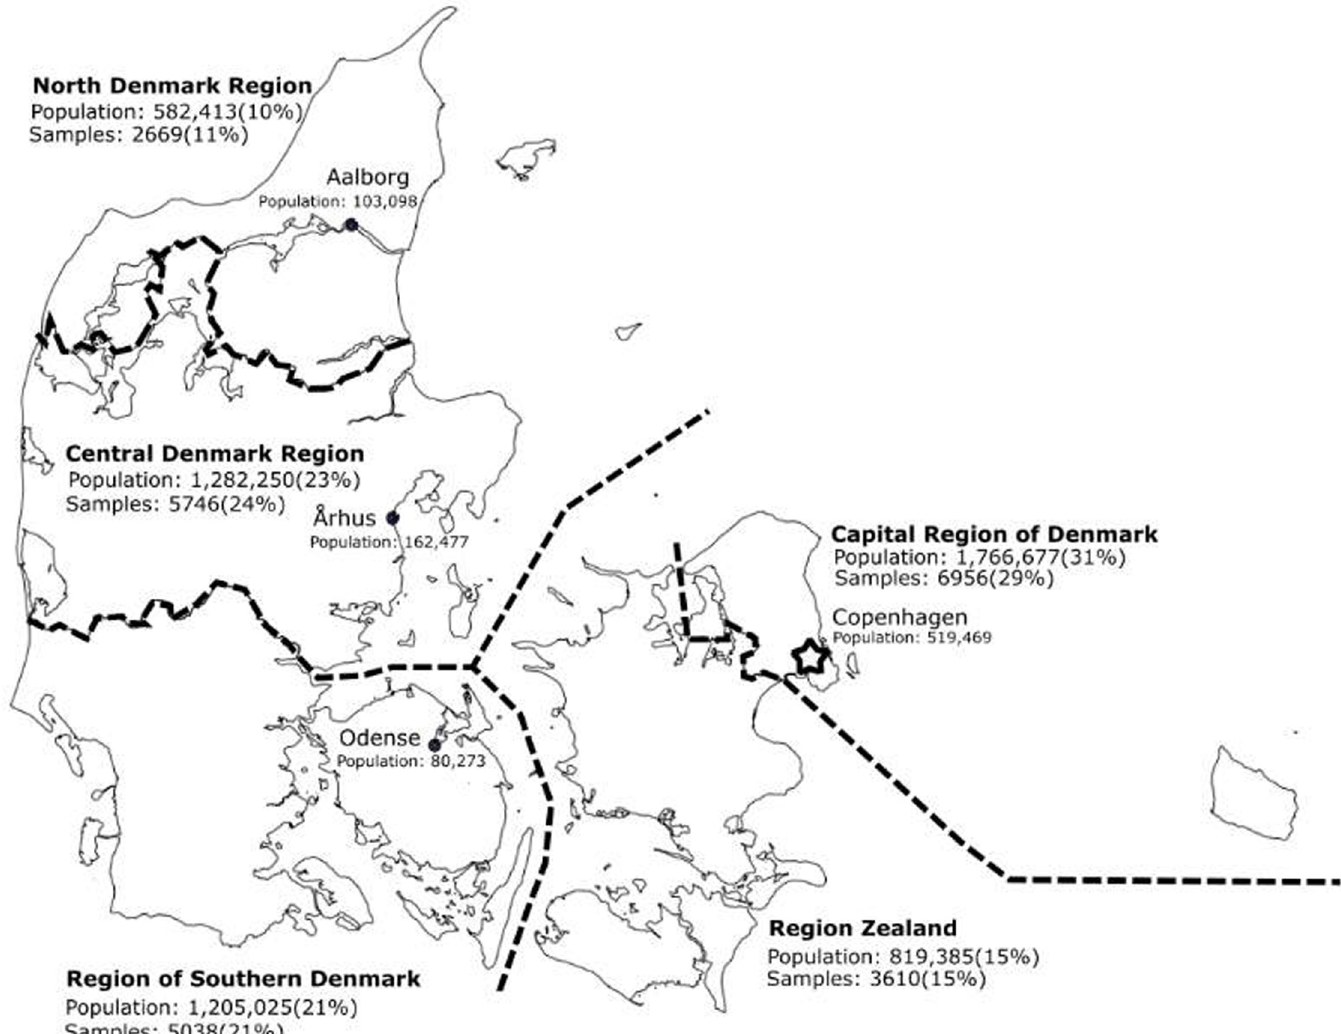
Fig 2. Map of Denmark with major administrative regions and metropolitan areas. The population of each region or area, as well as the number of samples, is given on the map. Based on birth-locations with � 20 included individuals.